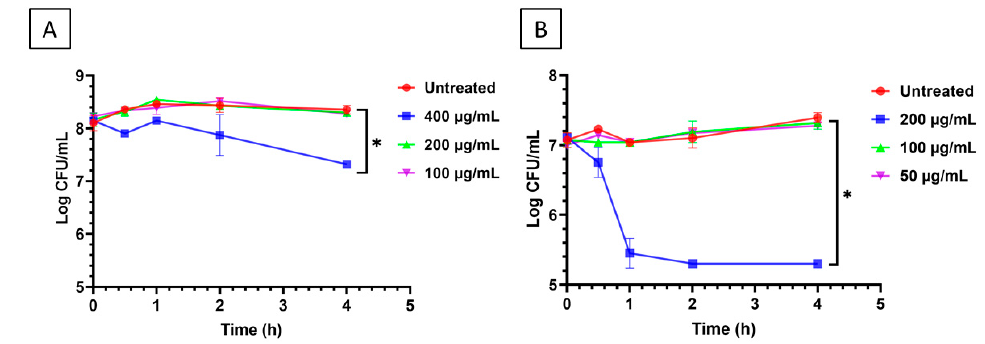
Figure 2. Changes in populations of desiccation-adapted Salmonella Tennessee E2007000304 when exposed to different concentrations of carvacrol (panel ( A )) or thymol (panel ( B )) for up to 4.0 h at 22–25 °C. Each data point represents mean ± standard deviation. Asterisk (*) denotes significant difference ( p < 0.05) after 4.0 h of incubation.